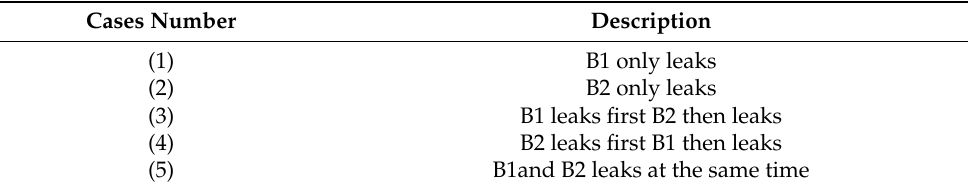
Table 4. Five scenarios list.